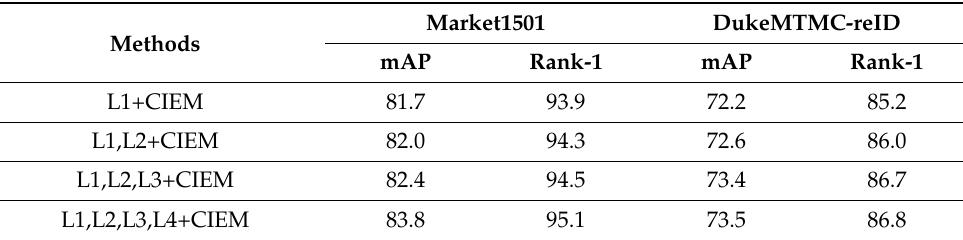
Table 2. Model performance (%) after adding contour information extraction module at the output position of different residual layers.